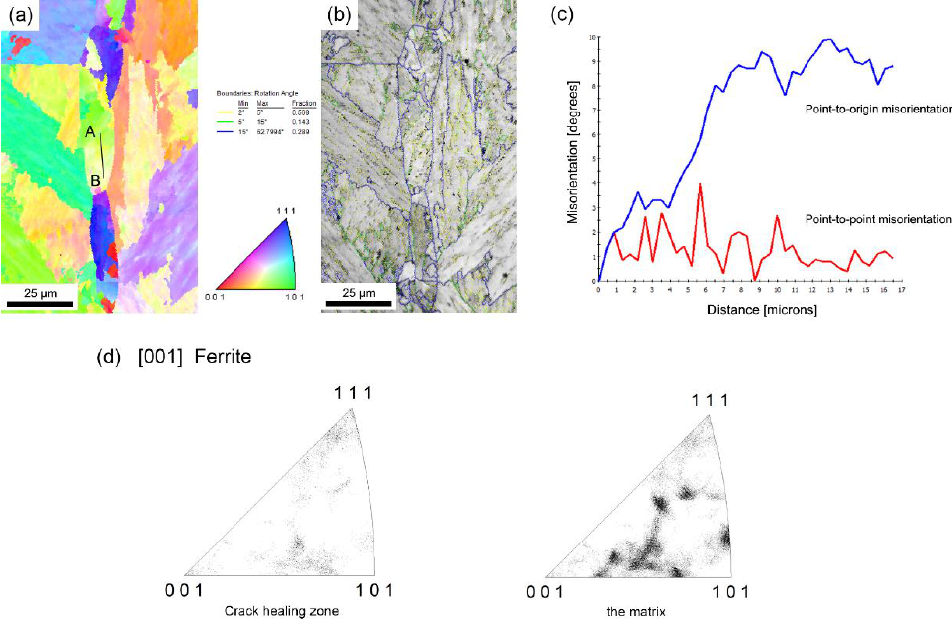
Figure 6. ( a ) An inverse pole figure (IPF) map of the healing zone healed at 1150 °C, ( b ) the corresponding grain boundary map, ( c ) the misorientation profile along the line AB, and ( d ) the IPFs on the crack healing zone and the matrix.